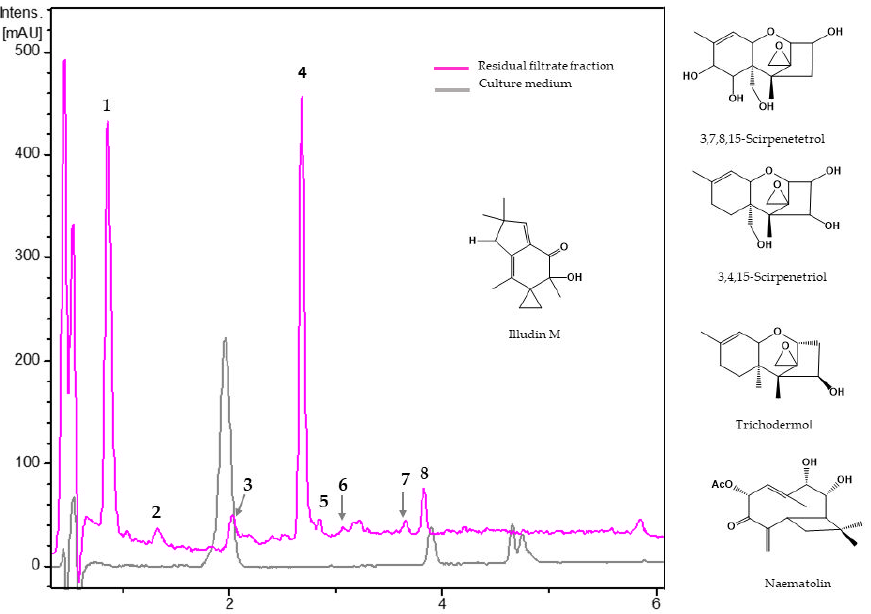
Figure 3. UV 210 nm chromatograms of residual filtrate fraction from Trichoderma harzianum Th43-14 and unfermented culture medium. 1 : Not identified (C 15 H 24 O 7 ), 2 : 3,7,8,15-scirpenetetrol, 3 : illudin M, 4 : not identified (C 14 H 22 O 4 ), 5 : 3,4,15-scirpenetriol, 6 : naematolin, 7 : not identified (C 29 H 44 O 10 ), 8 : trichodermol. Table 3. Dereplicated metabolites from residual filtrate fraction of Trichoderma harzianum Th43-14. No.